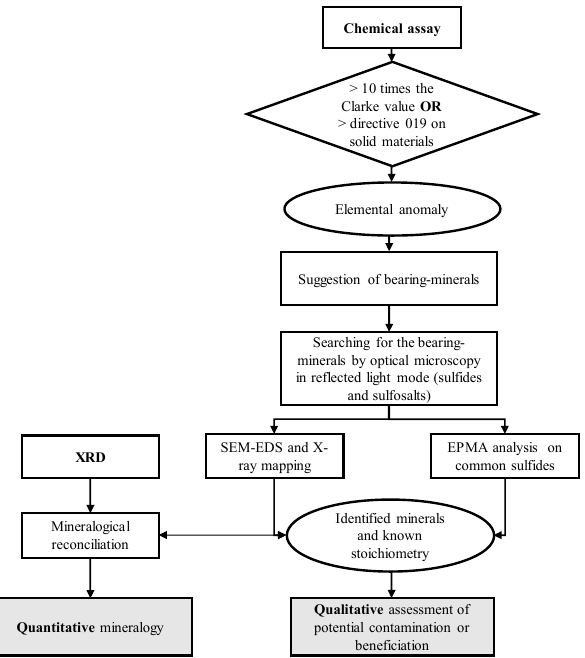
Figure 2. Logical diagram of the methodology of environmental and processing prediction applied at the stage of exploration. Then, a reconciliation of all the results is made by spreadsheet calculations to obtain a quantitative mineralogical characterization. The quantitative mineralogy was calculated with X‐ray powder diffraction (XRD) mineralogy, chemical assay, and stoichiometry of the minerals. This stoichiometry was either theoretical or determined by electron probe micro‐analyzer (EPMA).